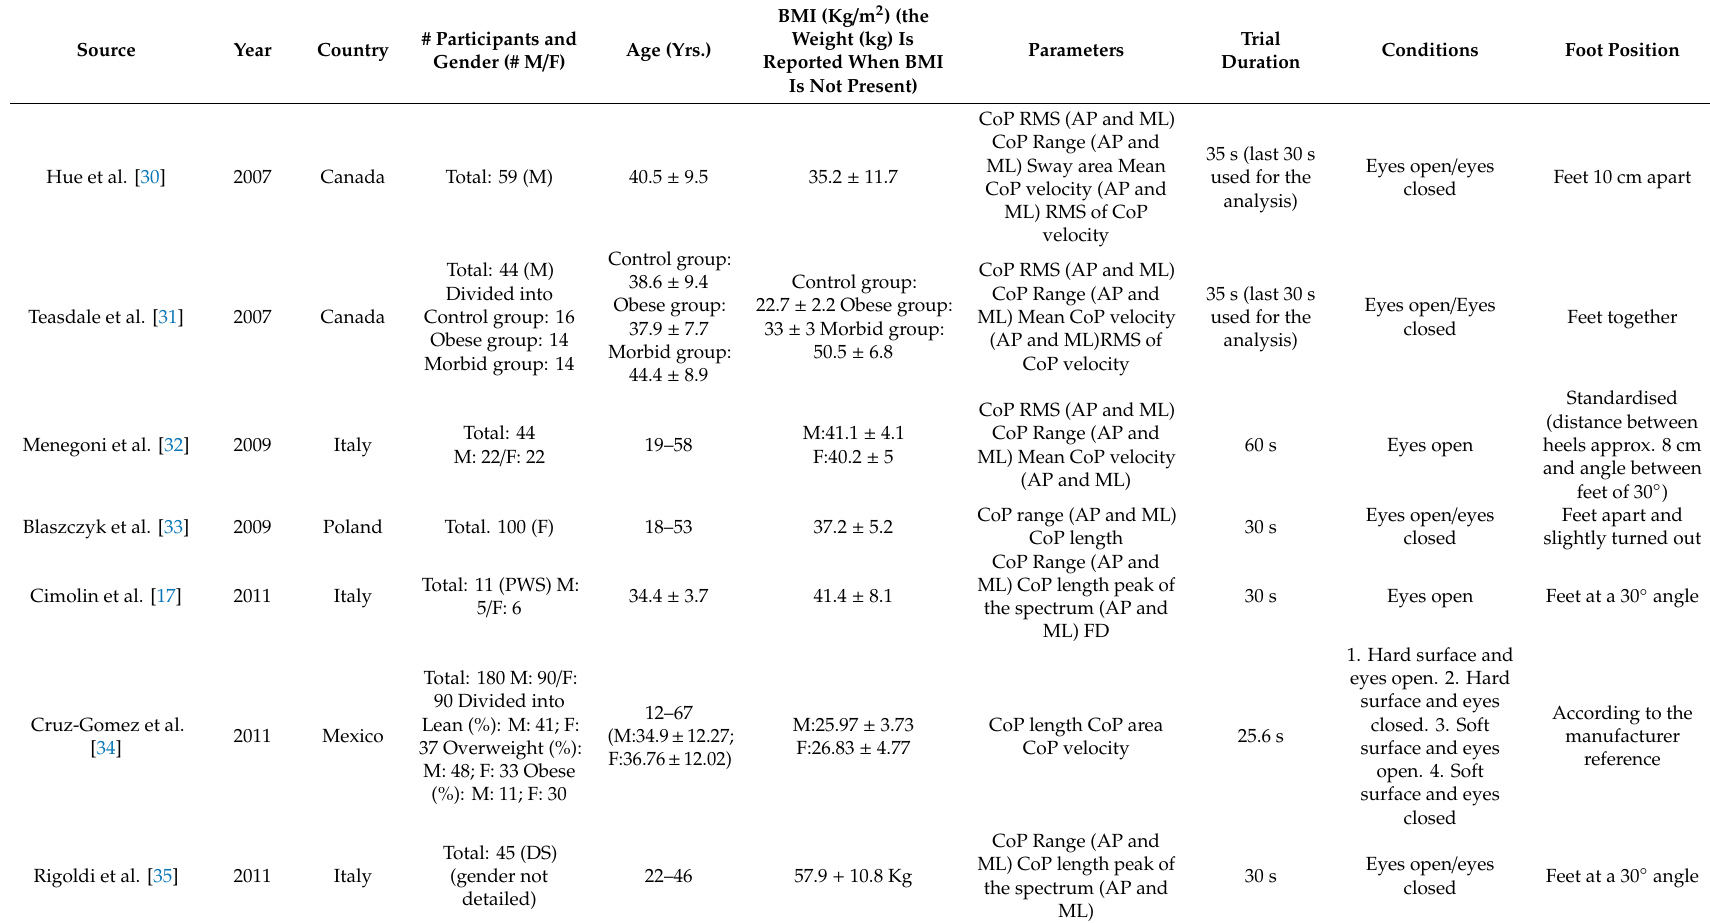
Table 1. Summary of the main details of the reviewed